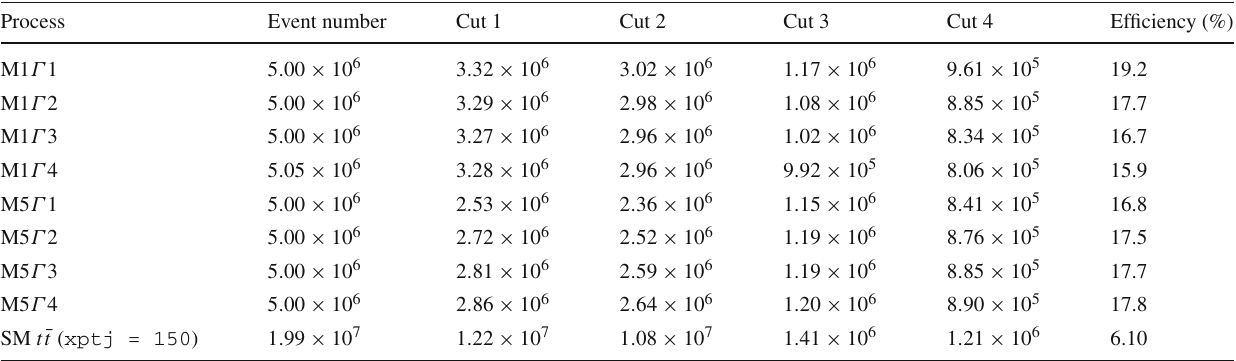
Γ ρ / M ρ = 0 . 1 × j . The setup xptj = 150 is to improve the event generating efficiency of the background, see the text for details